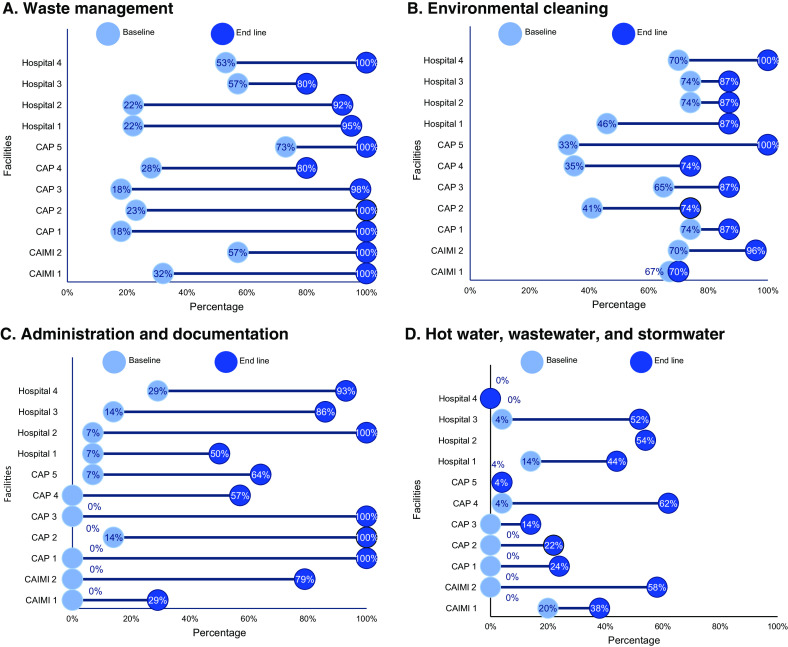
Baseline and End Line Assessment of Facility Compliance Level in Waste Management; Environmental Cleaning; Administration and Documentation; and Hot Water, Wastewater, and Stormwater Before and After Clean Clinic Approach Intervention, by Facility (N=11)